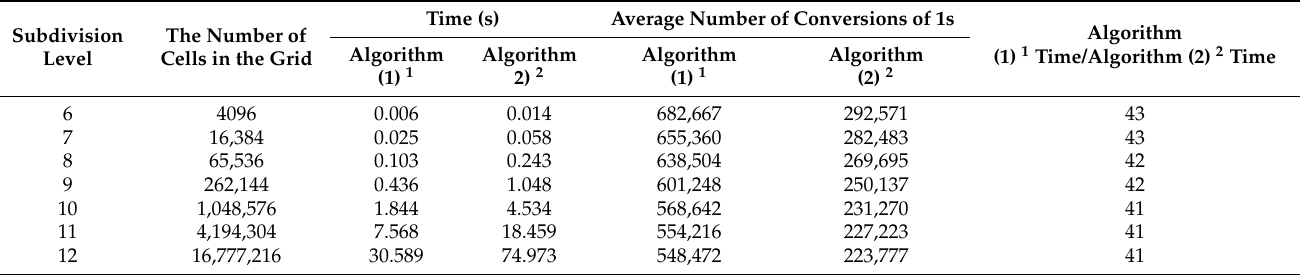
1 Row–column algorithm. 2 Three-orientation translating